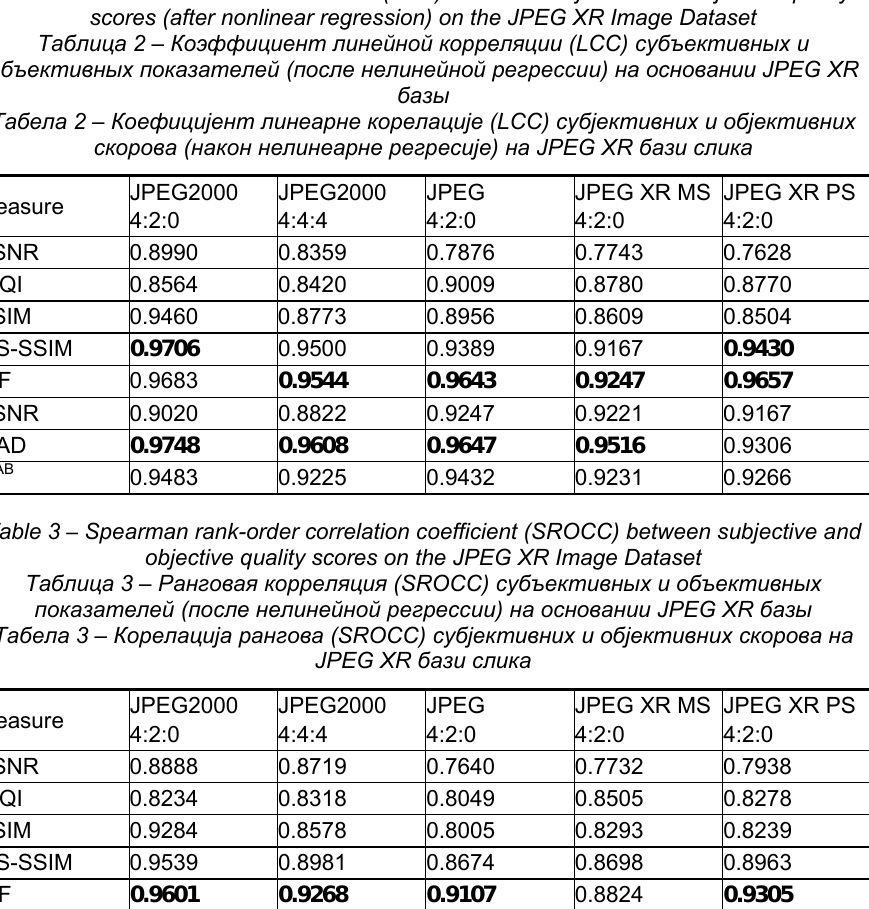
Table 2 – Linear correlation coefficient (LCC) between subjective and objective quality scores (after nonlinear regression) on the JPEG XR Image